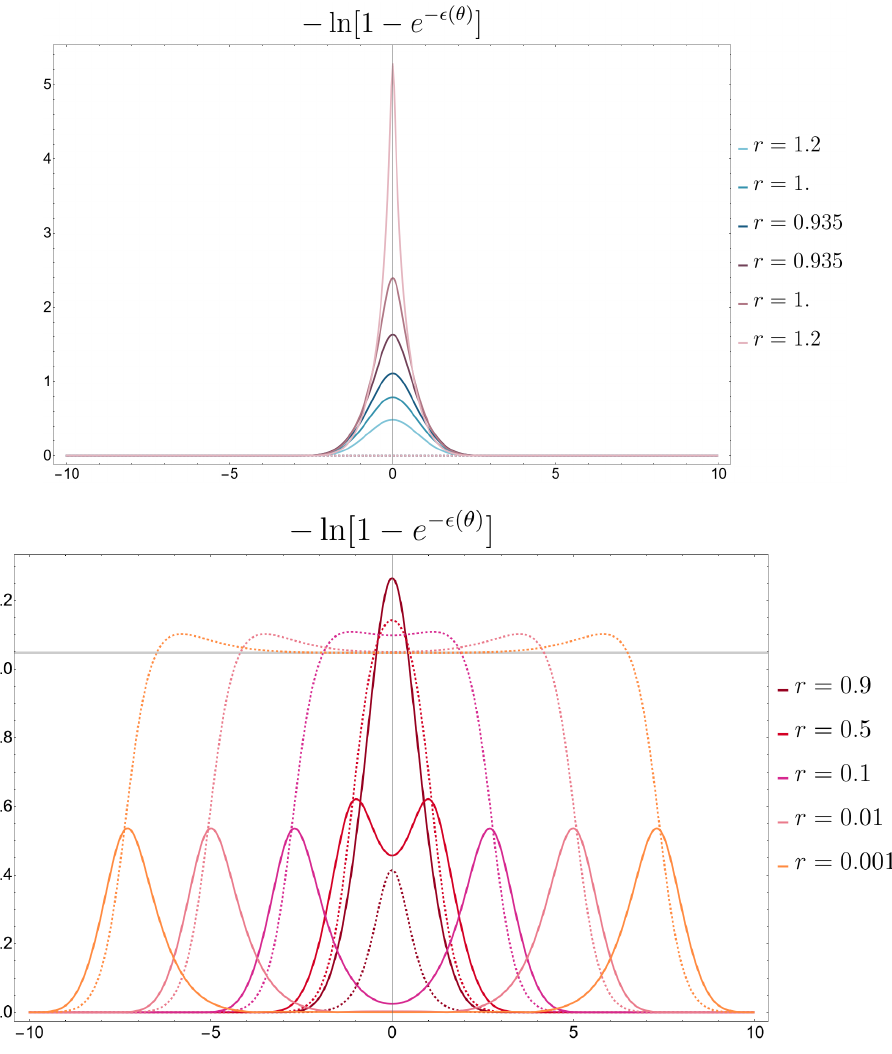
(cid:2) (cid:3) Figure 4. L ( θ ) = − ln 1 − e − (cid:15) ( θ ) functions for the bosonic sinh-Gordon model with a = 1 / 2 at different points along the curve of figure 3. The top figure shows the solutions for r > r c where we have two real branches ( r c ≈ 0 . 93 for a = 1 / 2 ). In blue we have the usual branch with free asymptotic behaviour (cid:15) ( θ ) ∼ r cosh( θ ) ; and in purple the second branch with asymptotic behaviour as in table 1. In the bottom figure we have the complex solutions below r c , which form a purely imaginary plateau (dashed lines) as r → 0